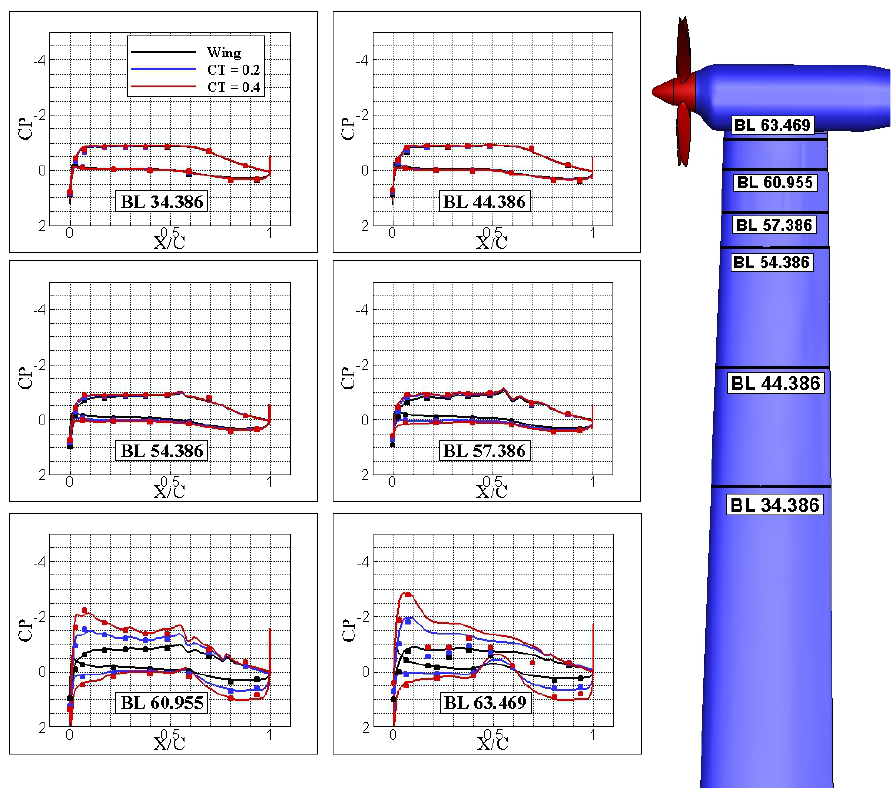
Figure 15. Surfaces pressure data of wing-propeller predictions at different thrust coefficients and α = 0 ◦ . Experiments are shown with circle markers. Lines correspond to Kestrel-predicted data using RANS